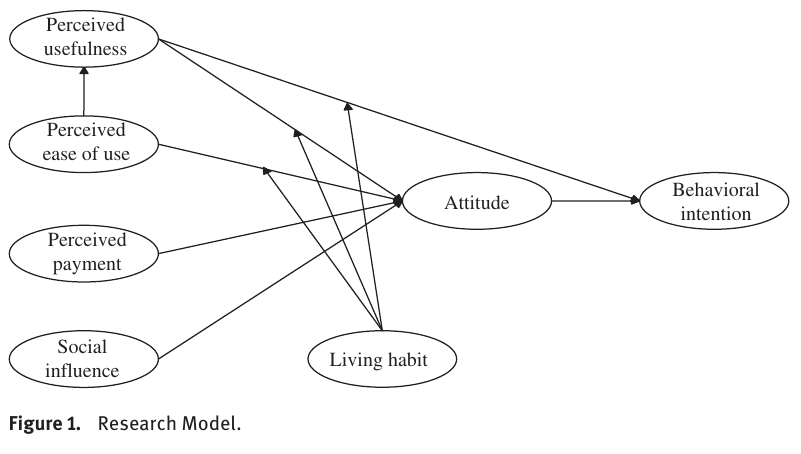
Figure 1. Research